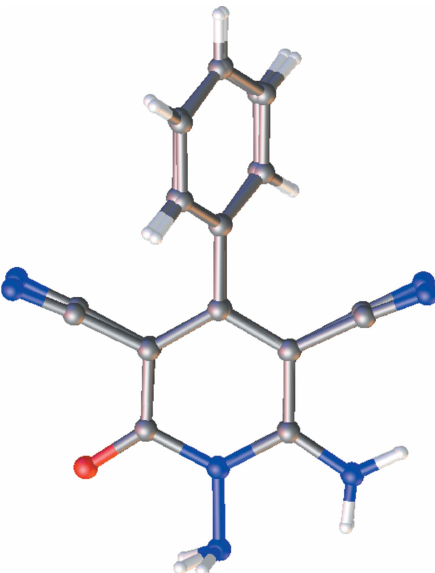
Figure 1 The molecular structure of compound (I) with displacement ellipsoids drawn at the 30% probability level. The O—H (cid:2)(cid:2)(cid:2) O hydrogen bond is drawn with a dashed line. Only the major component of the bromide disorder is shown for